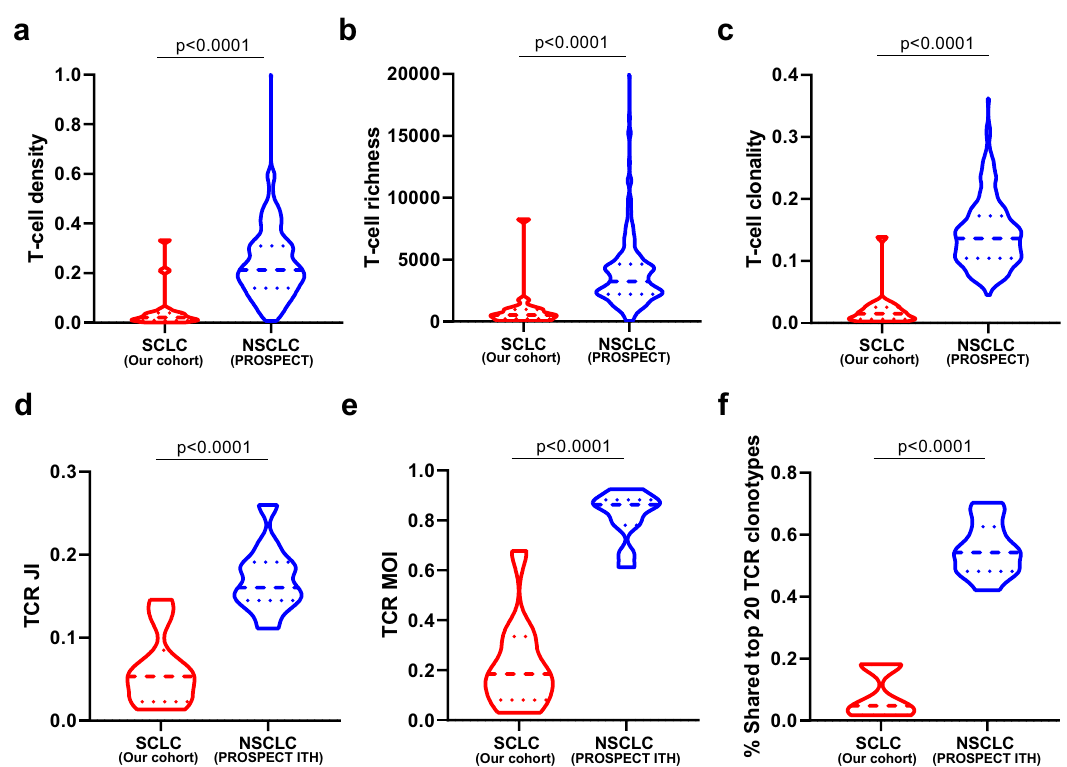
Fig. 2 TCR metrics in small-cell lung cancer (SCLC) versus non-small cell lung-cancer (NSCLC) tumors (the PROSPECT cohort). a T-cell density — an estimate of the proportion of T cells in a specimen, b T-cell richness — a measure of T-cell diversity and ( c ) T-cell clonality — a metric indicating T-cell expansion and reactivity, were derived from 19 SCLCs (red) versus 236 NSCLCs (blue) from the PROSPECT cohort. TCR intratumor heterogeneity (ITH) in 10 SCLC versus 11 NSCLC using ( d ) the average Jaccard index (JI), a metric representing the proportion of shared T-cell clonotypes, e Morisita index (MOI), a metric taking into consideration not only the composition of T-cell clonotypes but also the abundance of individual T-cell clonotypes and ( f ) proportion of shared top 20 TCR clonotypes between any paired samples within the same tumors in SCLC (blue) versus NSCLC tumors (red) with multiregional TCR data available. The difference of TCR metrics between SCLC and NSCLC was evaluated using two-sided Mann – Whitney test. Source data are provided as a Source Data fi